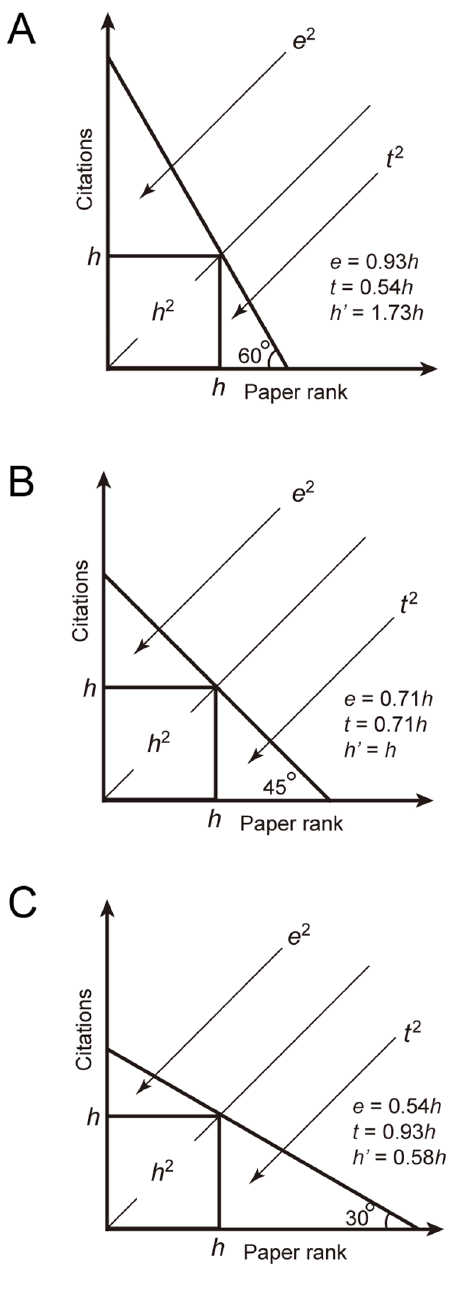
Figure 1. A straight-line model of the citation distribution function. The area under the citation distribution curve is divided by the h- index into three parts: the h 2 , excess citations ( (cid:2) e 2 ) and h- tail citations ( t 2 ). Here the citation distribution curve is simplified as a straight line. Cases shown in A, B and C all belong to an isohindex group, and they represent three types of scientists: A, perfectionist- type; B, prolific-type and C, mass producer-type [29], [30],